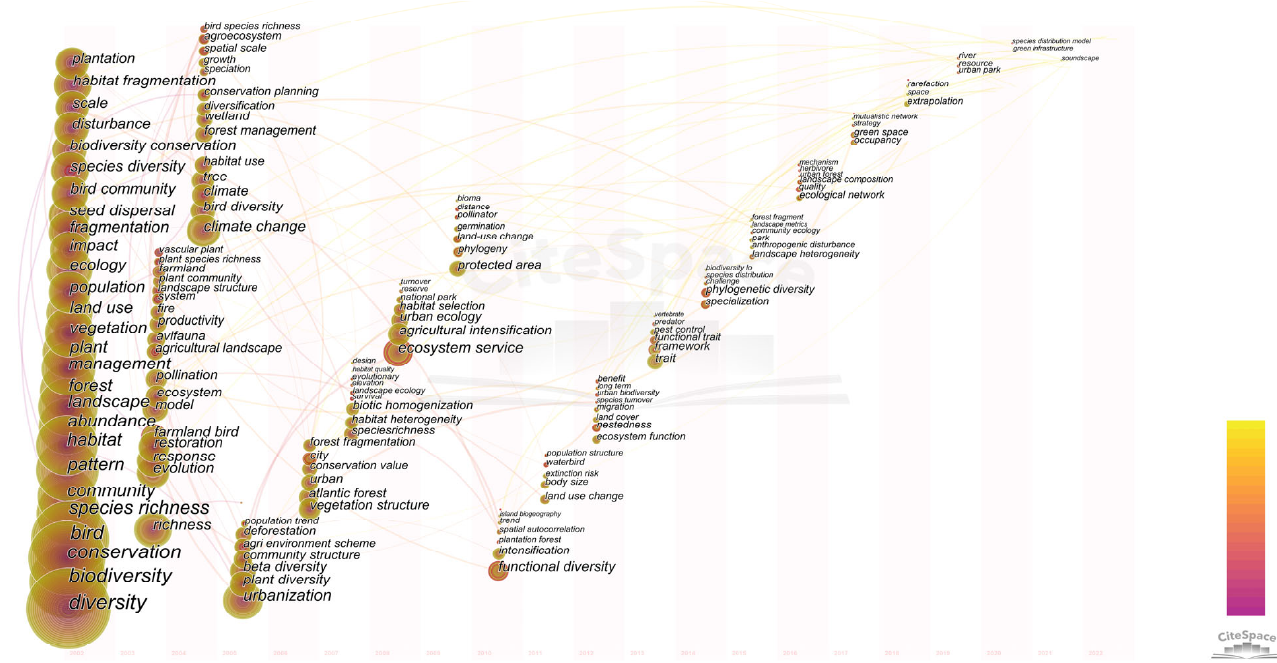
Figure 5. Research keyword time zone view map.